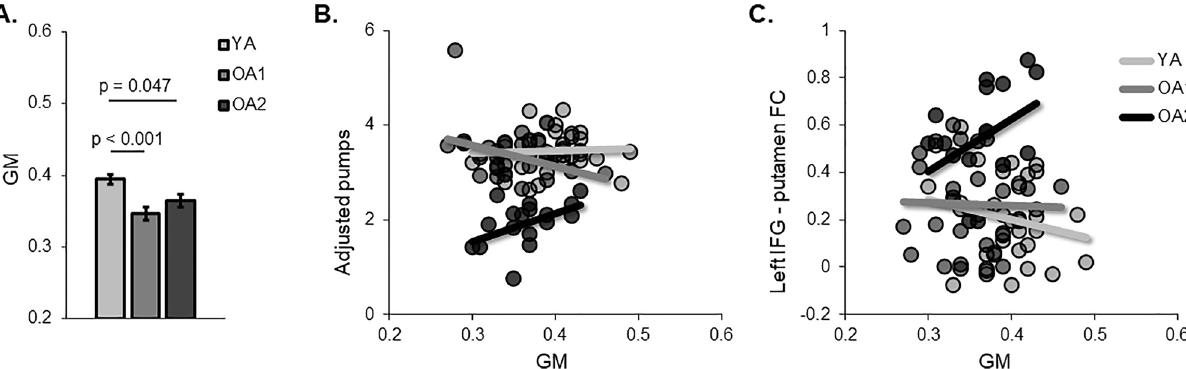
Figure 5. Group differences in the putamen GM and its relationship with risk behaviors. ( A ) The putamen gray matter volume was significantly decreased in the two old groups, compared with the young group (Bonferroni corrected p < 0.05). ( B ) A linear regression analysis was applied to examine the group differences in the relationships between GM and average adjusted number of pumps, showing significantly changed correlation in the OA2 group. ( C ) The relationship between GM and left IFG-putamen connectivity was significantly changed in the OA2 putamen functional network. Furthermore, the anatomical changes of the putamen were observed to be associ- ated with altered decision strategy and functional connectivity in over-conservative elderly group. Aging-induced brain deterioration affects cognitive function in multiple domains, particularly complex behaviors such as risk-taking behaviors 3 . Compared with young adults, older adults exhibited a greater prefer-